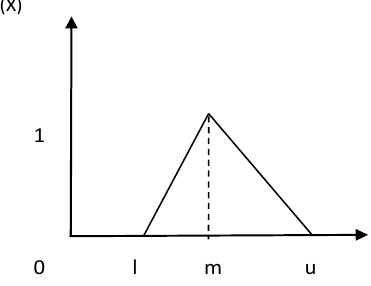
Figure 8. Triangular fuzzy number, A = ( l , m , u ). The l , m , and u values represent triangular fuzzy numbers. l = lowest value, m = most likely value, and u = highest value. The membership function of a triangular fuzzy number is represented as A = ( l , m, u ). In Equation (1), l , m , and u represent the lower limit, middle value and upper limit of the triangular fuzzy number A , respectively